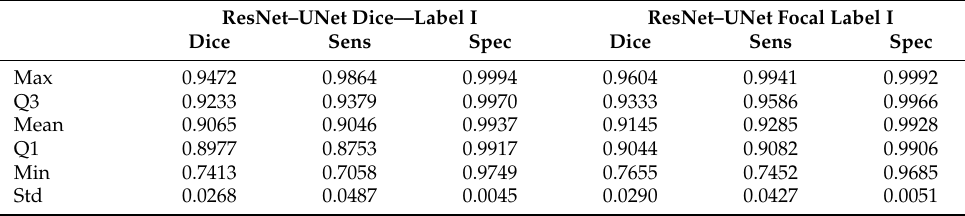
Table 4. Test set results of the ResNet–UNet network trained with Dice or focal loss in phase 1.